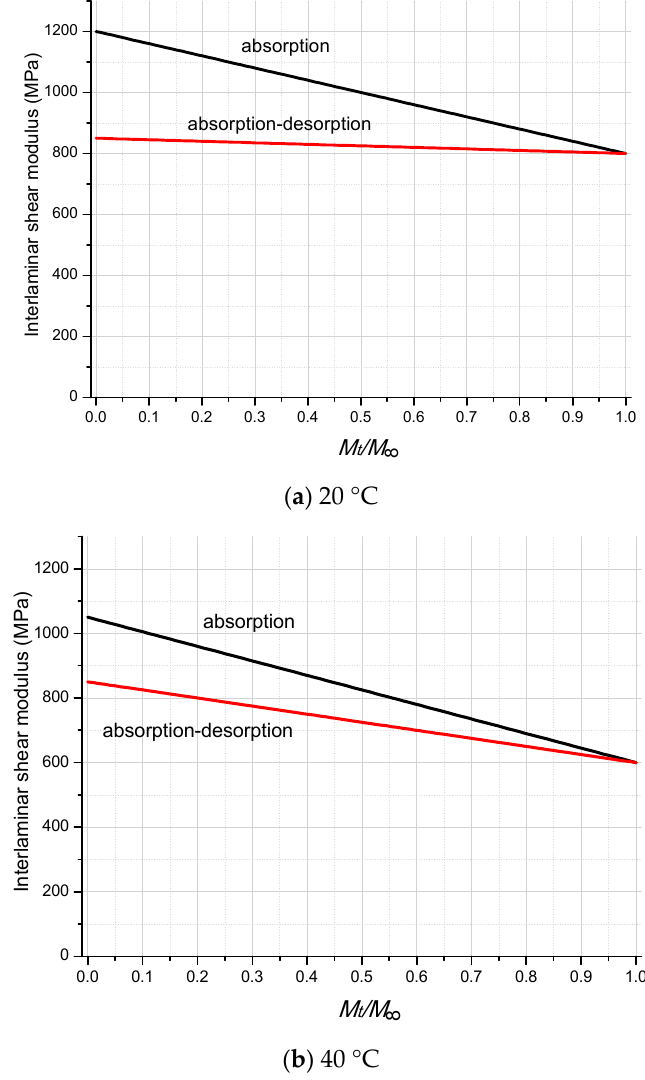
Figure 17. Degradation on the interlaminar shear modulus of GFRP laminates.